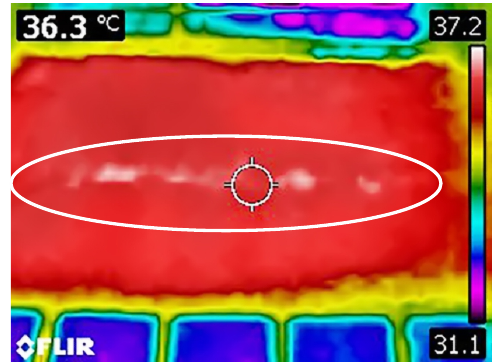
Figure 8. The sample image taken by FLIR thermal imager